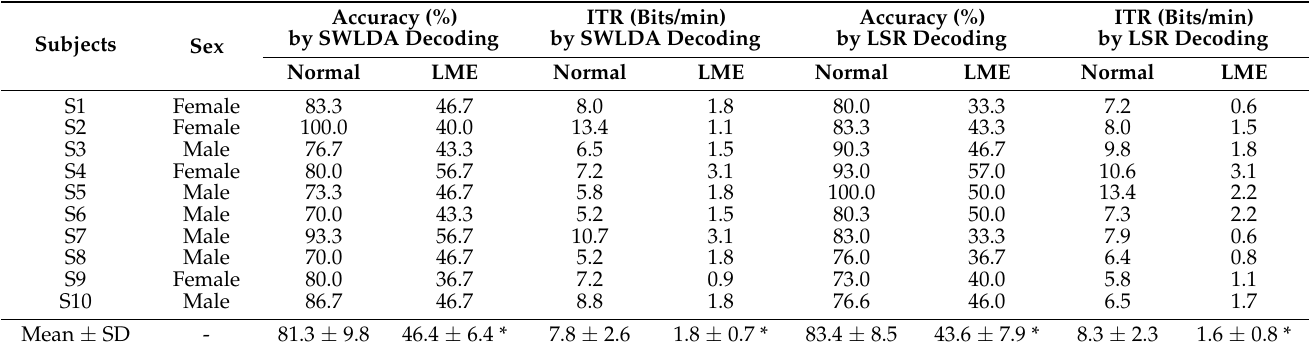
Figure 6. Amplitudes and SNRs in the Normal and LME Conditions. We plotted this figure using the EEG signals collected in the online phase of the normal and LME condition experiments. The subfigures ( A , B ) showed the amplitudes and SNRs of the collected EEG signals, respectively. In this figure, “*” means that the results were significantly different ( p < 0.001).